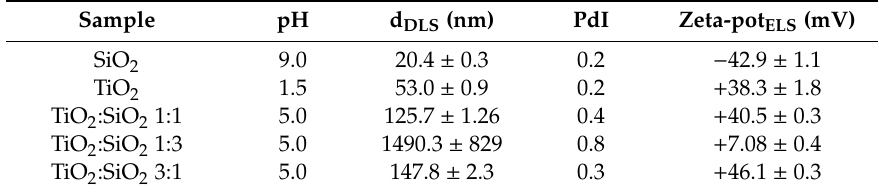
Table 1. Colloidal properties of NPs. Hydrodynamic diameter (Z-average), polydispersity index (PdI) and zeta potential ( ζ -potential) of TiO 2 :SiO 2 nanoparticles (NPs) in water.